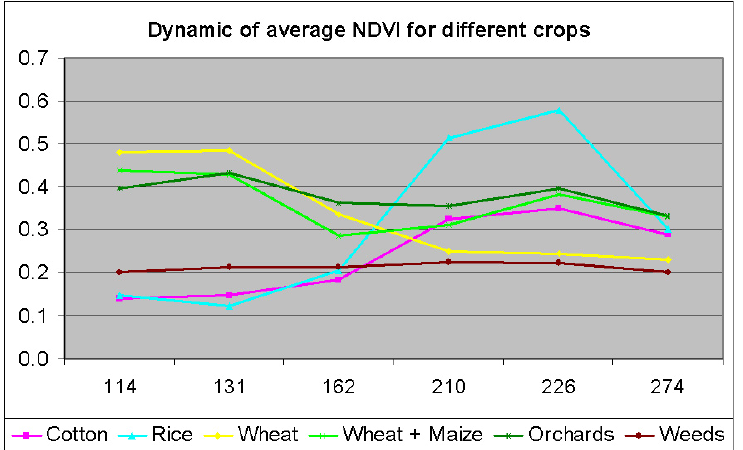
Figure 5. Dynamic of average NDVI for different crops in Galaba study area, derived from Landsat ETM+ images for 2006